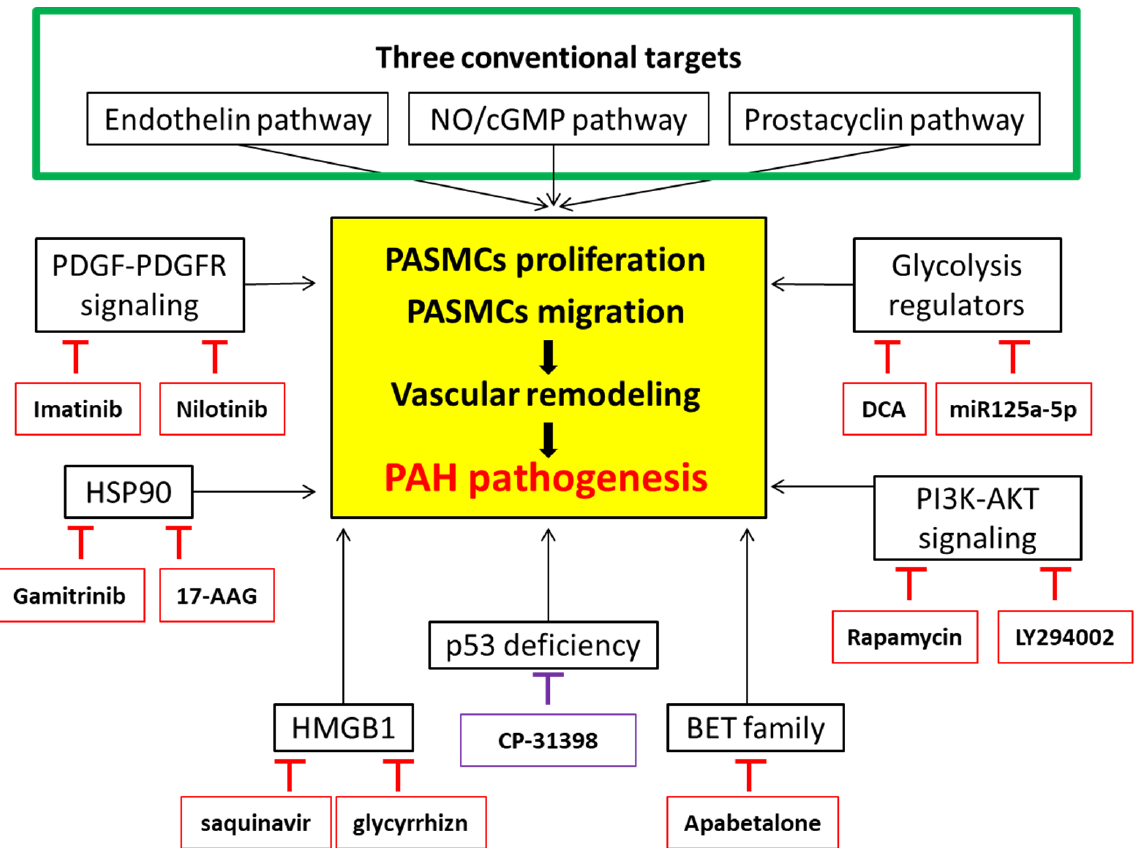
Figure 3. The graphic summary of the pathogenesis of PAH and the potential therapeutic targets in treating PAH. Three major cellular signaling pathways have been conventionally identified for targeted therapy in pulmonary arterial hypertension (PAH): (1) The endothelin pathway, (2) nitric oxide (NO)/cyclic guanosine, the monophosphate (cGMP) pathway, and (3) the prostacyclin path- way. In combination, abnormalities in these pathways contribute to PAH pathogenesis caused by vascular remodeling as a result of the proliferation and migration of pulmonary arterial smooth muscle cells (PASMCs). Receptor tyrosine kinase inhibitors (Imatinib, Nilotinib) are used to reduce the effect of platelet-derived growth factor receptors (PDGFR), which are the predominant triggers of unregulated PASMCs’ proliferation and migration, leading to vascular remodeling. 17-AAG, a heat shock protein 90 (HSP90)-inhibitor, and gamitrinib, a mitochondrial matrix inhibitor, can be used to downregulate HSP90, thereby reducing cell proliferation. Saquinavir and glycyrrhizn can also decrease cell proliferation and migration in PASMCs by inhibiting the high-mobility group box- 1 (HMGB1). Pharmacological induction of the p53 expression/activity by using a p53 stabilizing agent, CP-31398, can also counteract the effect of p53 silencing or deficiency. Apabetalone, the orally available bromodomain and extra-terminal motif (BET) inhibitor, blocks the binding between acet- ylation on chromatin histones and BET proteins, which normalizes hemodynamics parameters and pulmonary vascular remodeling in PAH. Suppressing PI3K/AKT by using the small molecular in- hibitor, LY294002, may also reverse hypoxia-induced anti-apoptotic PASMCs’ proliferation, as well as inhibit the mammalian target of rapamycin (mTOR), one of the major downstream effectors of the PI3K/AKT pathway, via rapamycin. Dichloroacetate (DCA) and the non-coding micro-RNA, miR125a-5p, targeting hexokinase 2, can decrease glycolysis while increasing mitochondrial respi- ration.